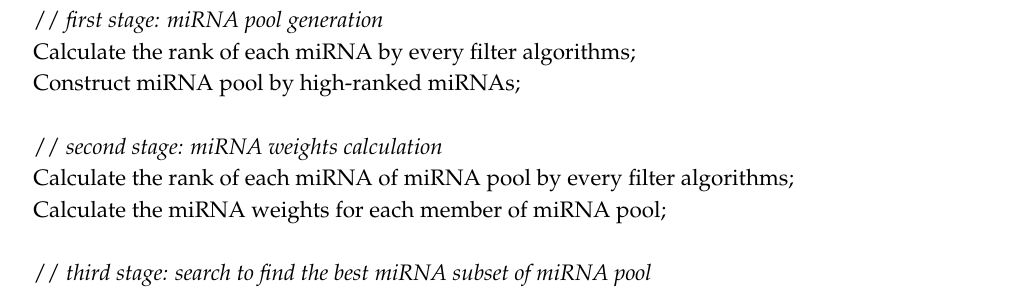
Algorithm 1. General outline of proposed